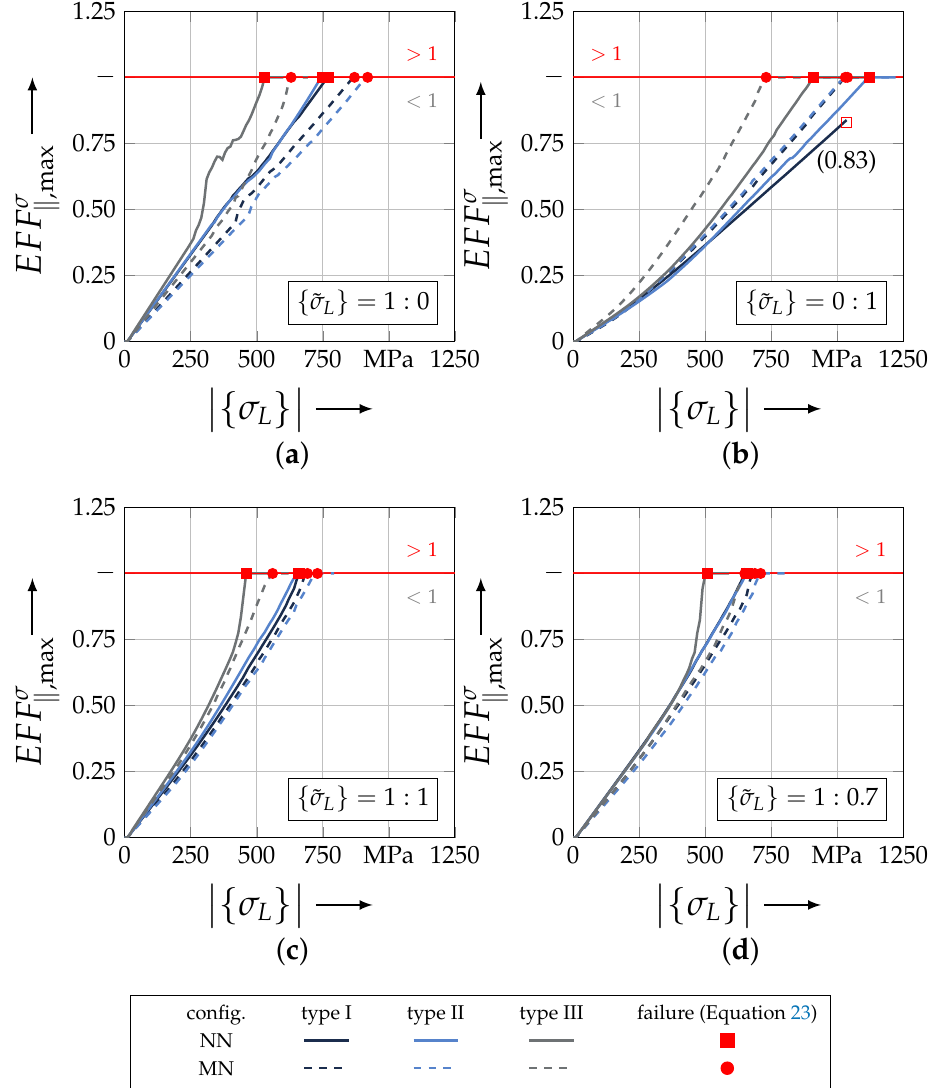
Figure 19. Results of the failure identification according to Equation (23) ( EFF σ rUCs at selected load paths { ˜ σ L } = ( a ) 1:0, ( b ) 0:1, ( c ) 1:1 and ( d )